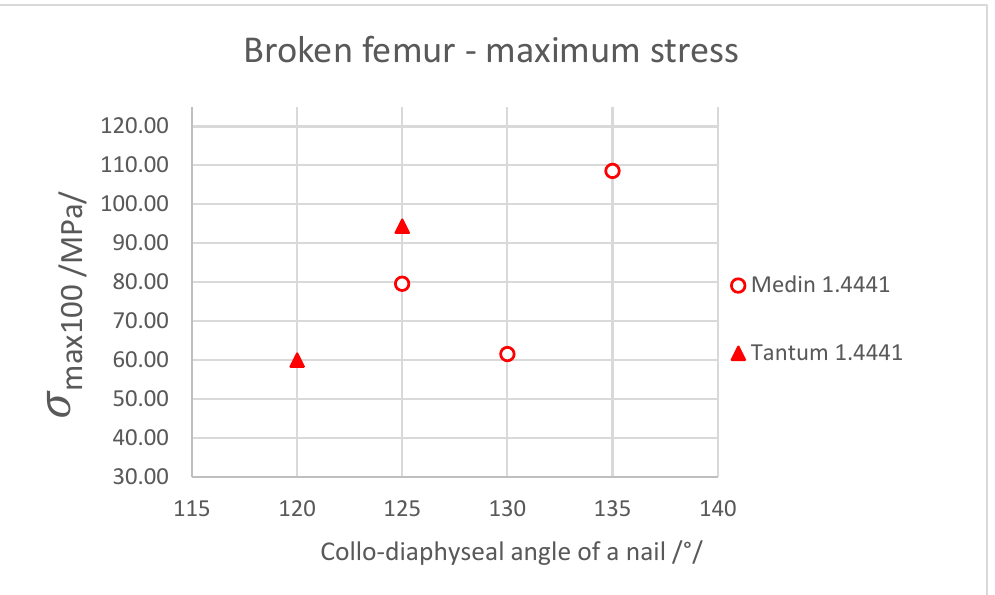
Figure 18. Dependence of maximum HMH stress (MPa) on nail collo ‐ diaphyseal angle (broken femur).